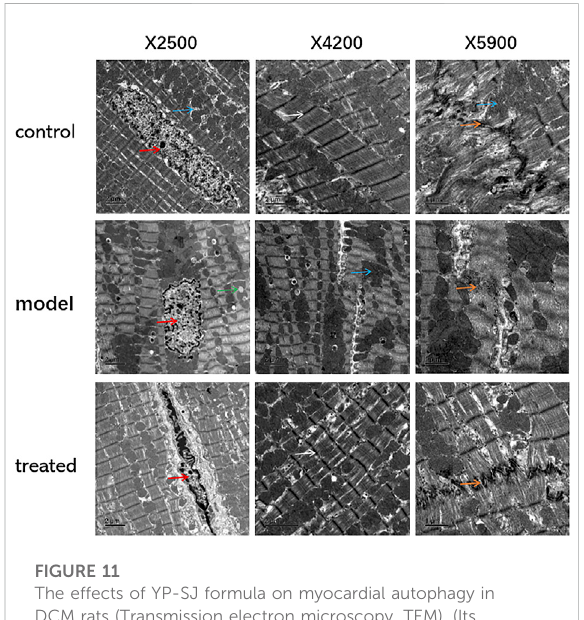
FIGURE 11 The effects of YP-SJ formula on myocardial autophagy in